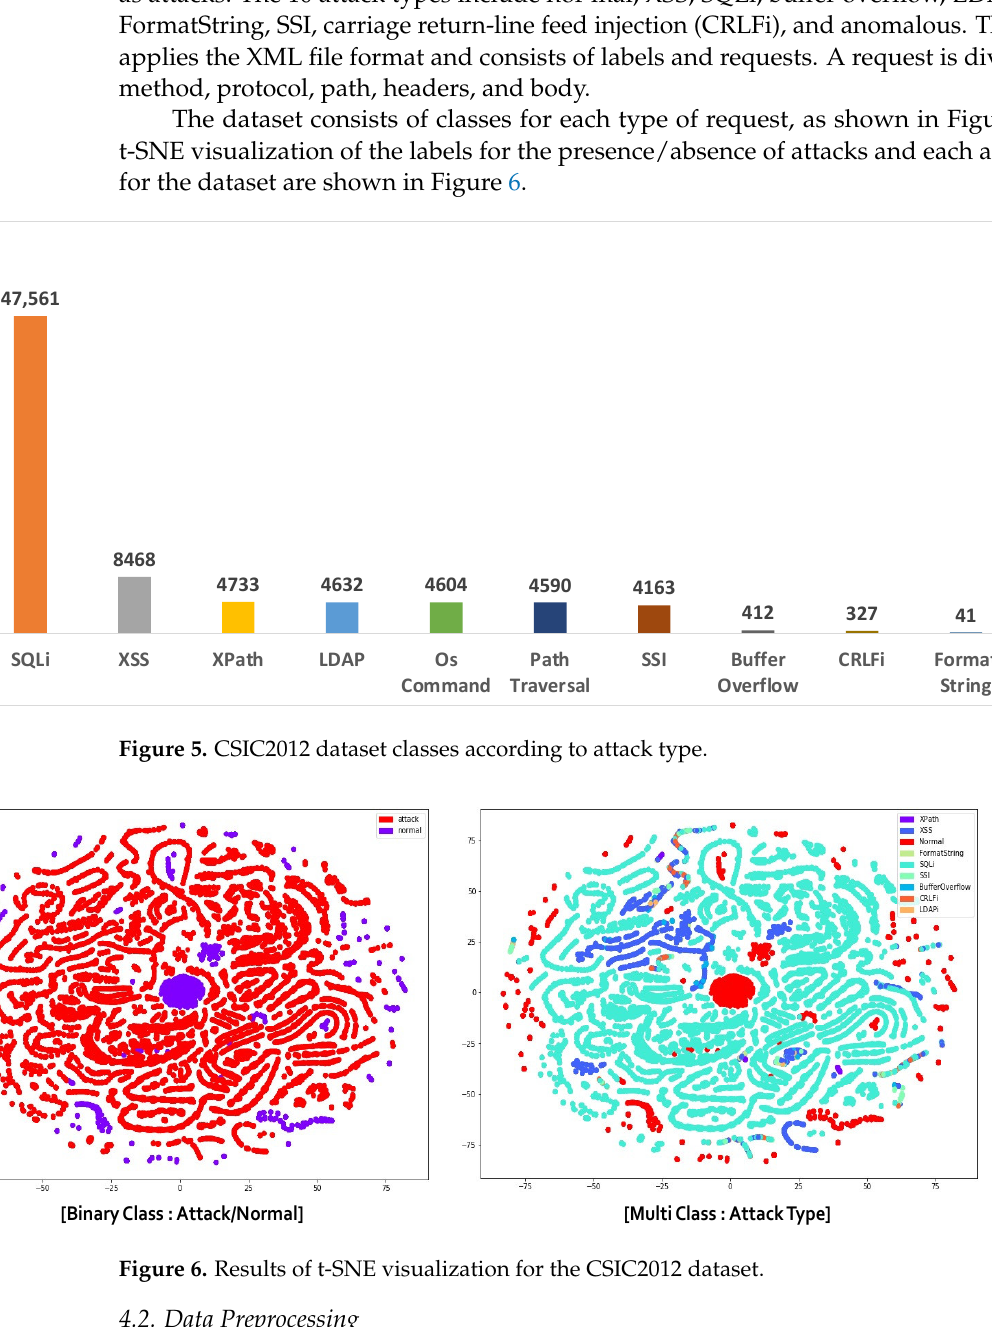
Figure 4. Results of t-SNE visualization for the PKDD2007 dataset.